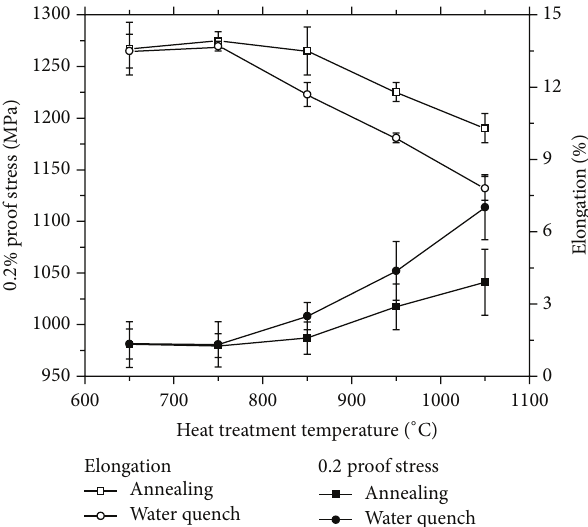
Figure 5: X-ray diffraction pattern of PM, 950A, 1050A, and 1050Q.